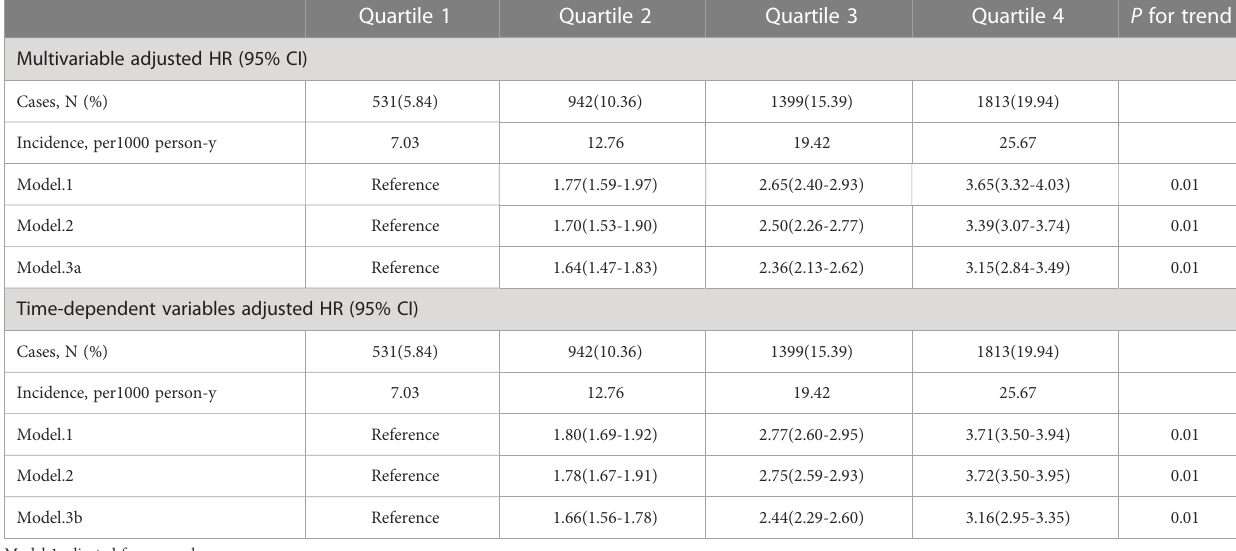
TABLE 2 Hazard ratios (95% CI) for risk of outcomes according to quartiles of Average TyG-index (1 st measurement to end of follow-up).